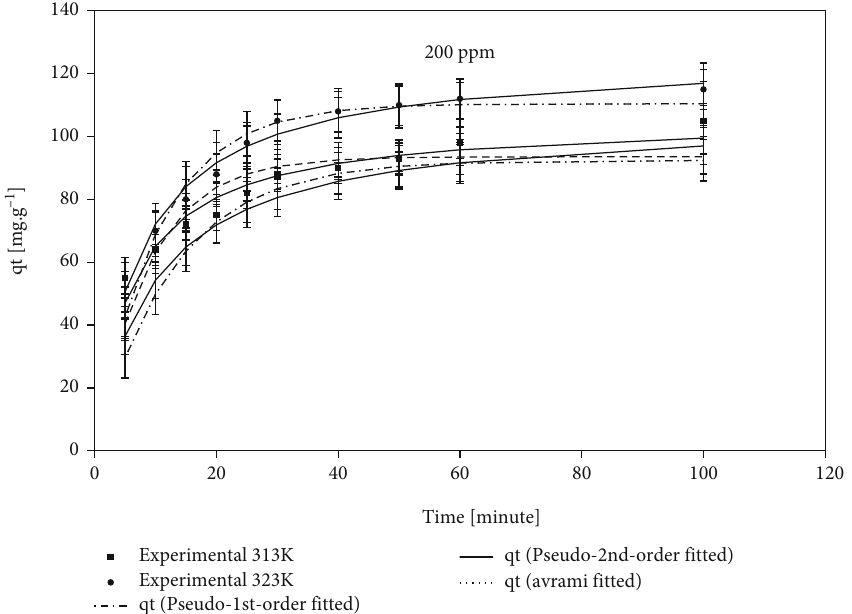
Figure 16: 200ppm CV concentration on PSS kinetic model fi t at temperatures 303 K, 313K and